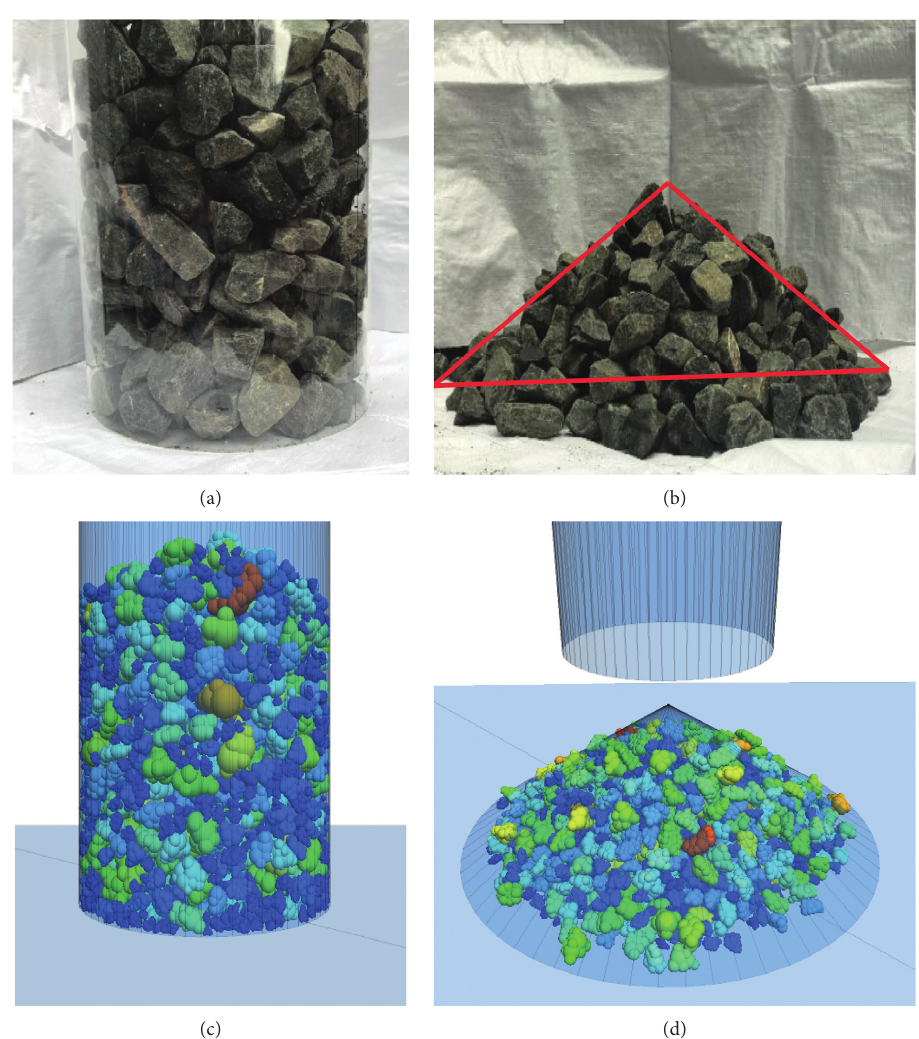
Figure 3: The cylinder lifting test: (a) loaded ballast in the cylinder; (b) ballast pile under gravity; (c) DEM model; (d) measurement cone in PFC3D. Table 1: The parameters of the linear contact model.